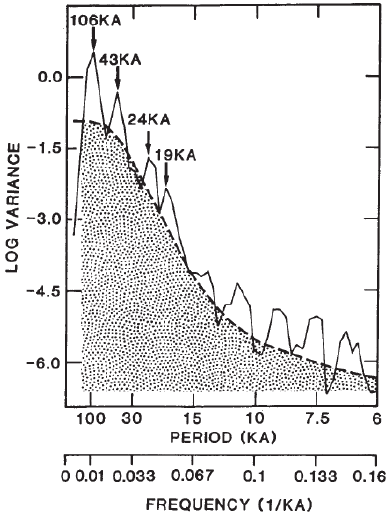
Figure 1. Power spectrum of a composite δ 18 O record using deep- sea cores RC11-120 and E49-18. This figure is based on the work of Hays et al. (1976), as presented by Imbrie and Imbrie (1986). Reprinted by permission from Springer Nature Customer Service Centre GmbH: Springer Nature. Topics in Geophysical Fluid Dy- namics: Atmospheric Dynamics, Dynamo Theory, and Climate Dy- namics by Ghil and Childress (1987), © 1987 by Springer Sci- ence+Business Media New York. All rights reserved.